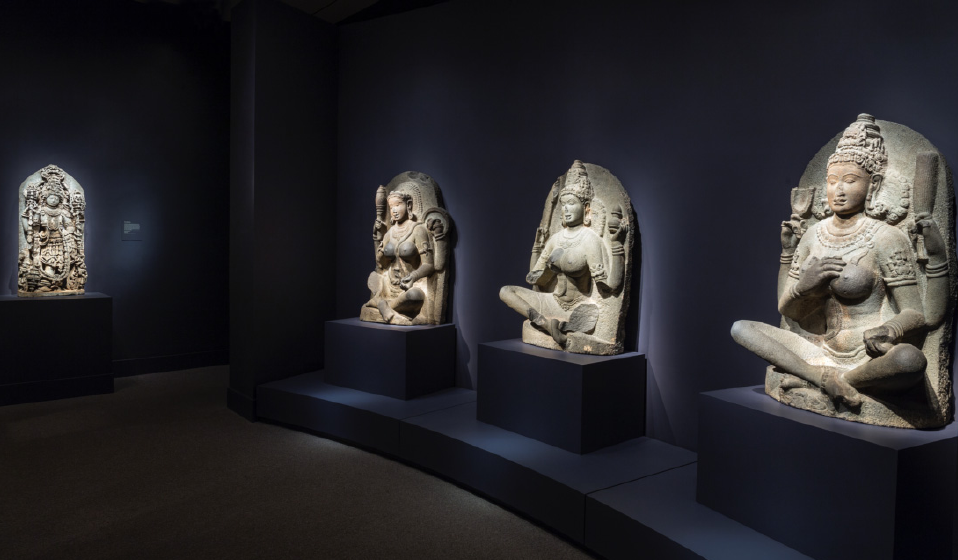
Figure 21. Yoginis exhibited in Yoga: The Art of Transformation , Arthur M. Sackler Gallery, Smithsonian Institution, Washington, DC, 2013.